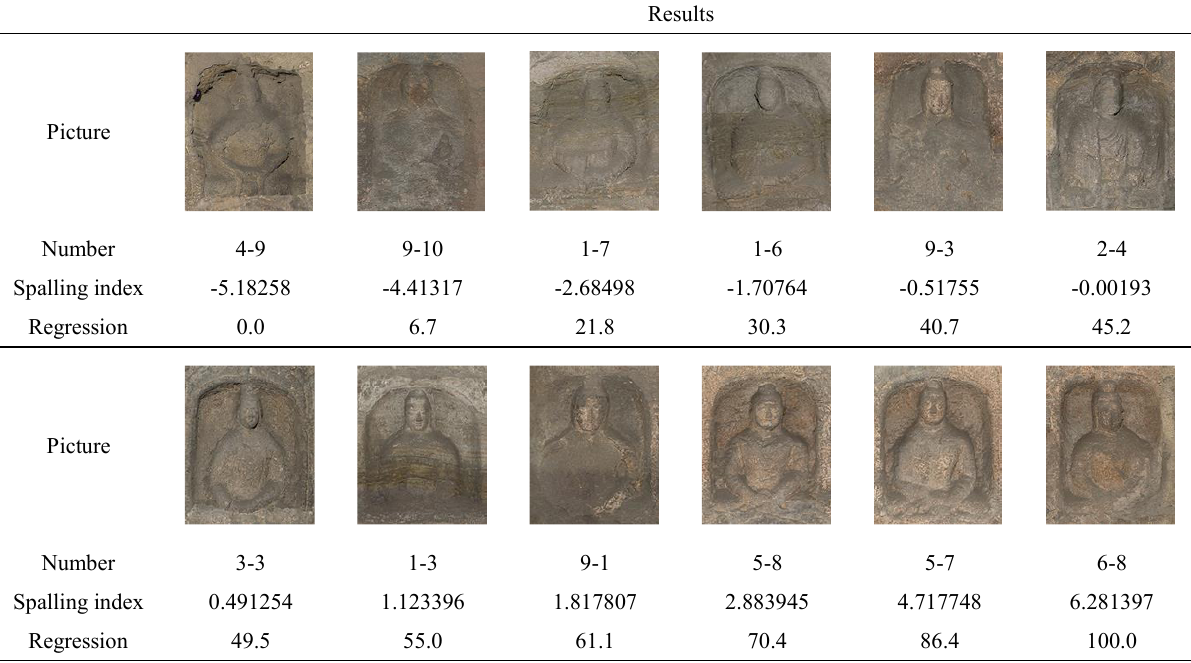
Comparison of quantitative evaluation